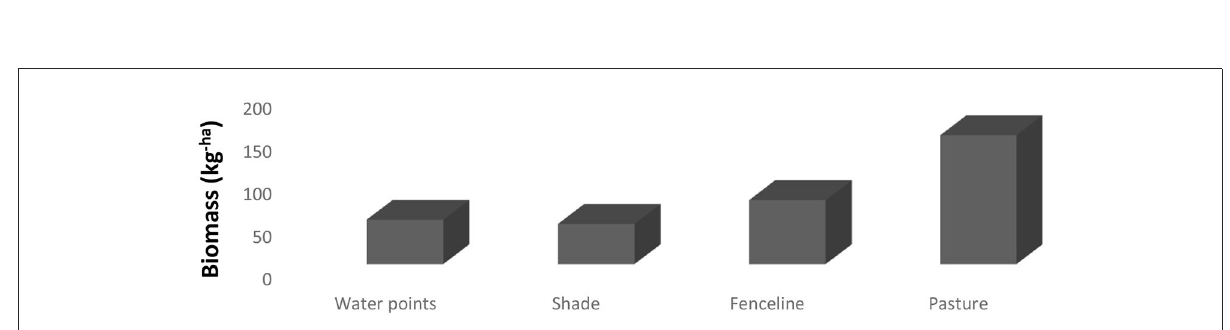
FIGURE4 Mean forage biomass production (kg ha − 1 ) in different locations within a